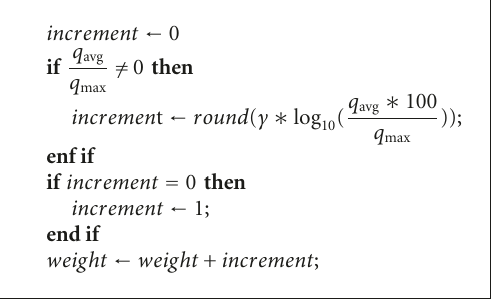
Algorithm 2: Additive increase.